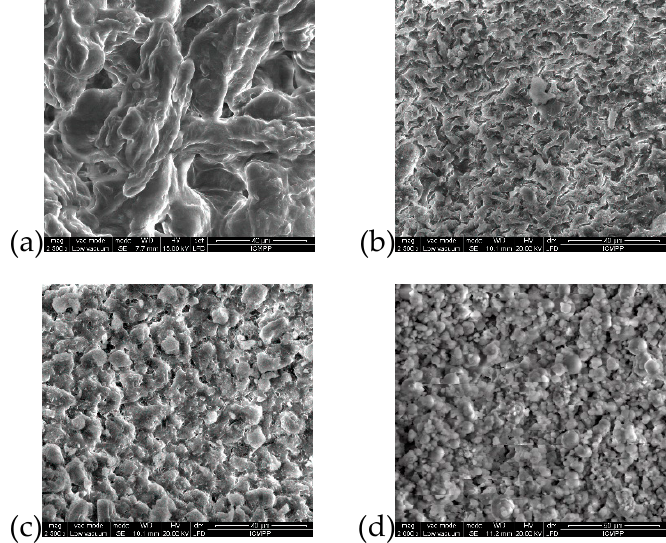
Figure 2. SEM images of RAB ( a ), AWB ( b ), Alg ( c ) and Fe-NPs_alg ( d ).